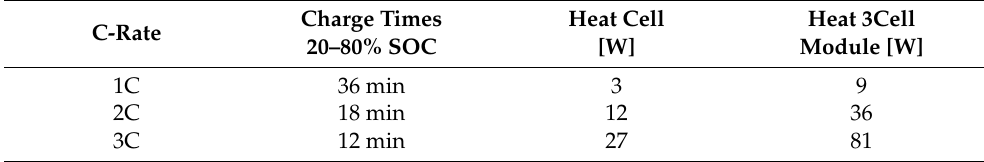
Figure 10. Power vs. time (in minutes) profiles of the different C-rates used in this investigation. These figures refer to a 20% to 80% SOC charge. Table 7. Duration and average heat generation rate of single cell and module, considering a fast charge from 20% to 80% depending on the different C-Rates.